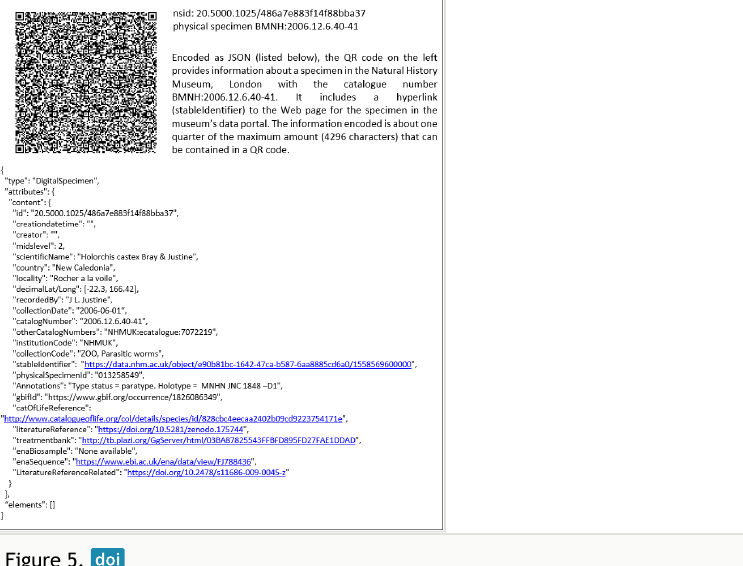
Figure 5. An example matrix (QR) code encoding information about a